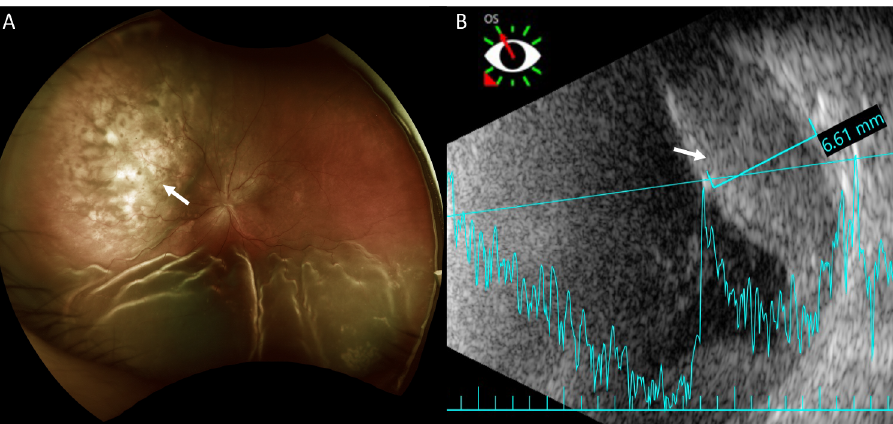
Figure 2. Fundus photography and B-scan ultrasonography of the left eye. ( A ) Fundus photography shows exudative retinal detachment in the inferior retina and an amelanotic choroidal mass in the superior quadrant (arrow) in marked relief. Exudative retinal detachment is seen mainly on the sides of the choroidal mass. ( B ) Ultrasonography shows the achromic mass in the superior region as a hyperechoic lesion in the subretinal region (arrow) with a thickness of approximately 6.61